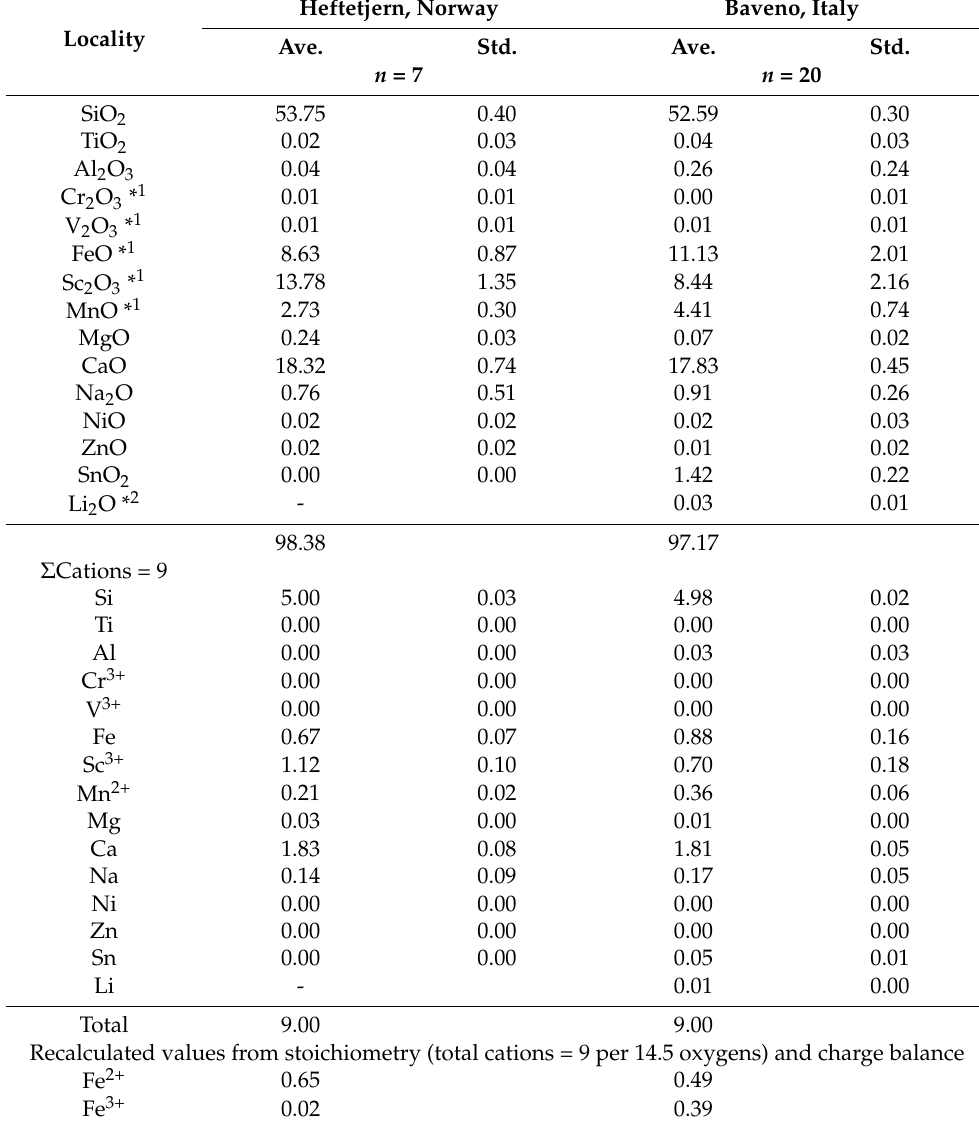
Table 1. Chemical compositions of Sc-rich babingtonites.